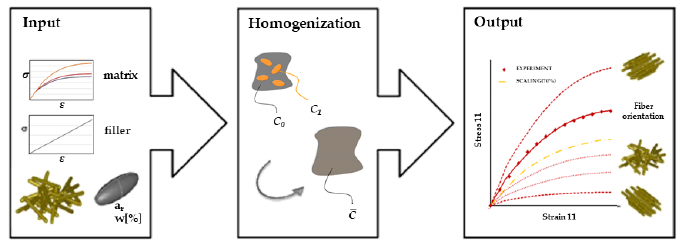
Figure 1. Flowchart of DIGIMAT-MF module [18]. Table 1. Material parameters of used resins and fibers. Performance Parameter